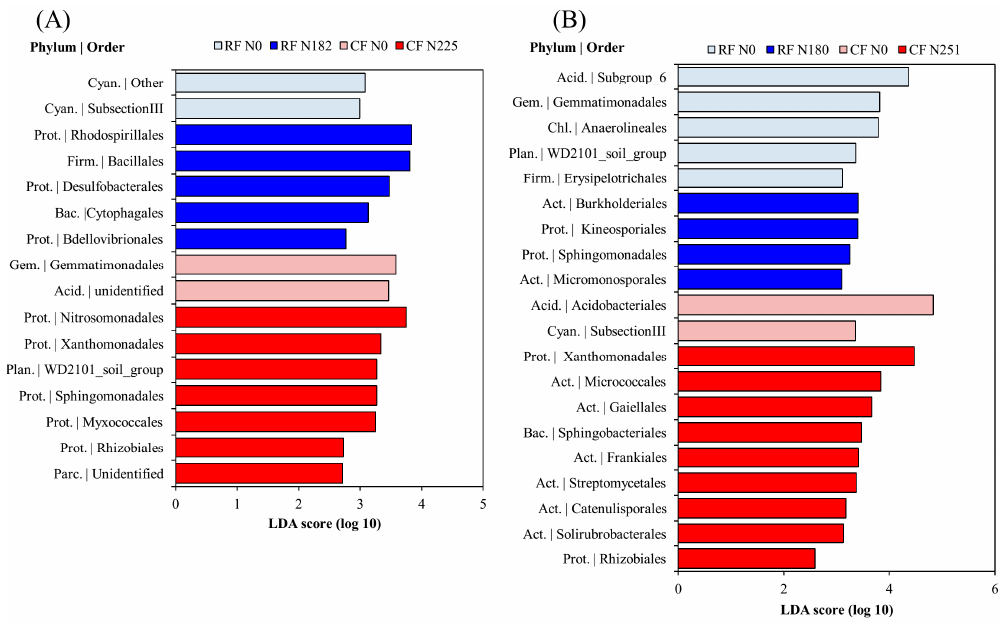
Figure 5. Bacterial key phylotypes (at the order level) significantly altered under RF and CF fertilization identified using linear discriminant analysis (LDA) effect size (LEfSe) in fluvo-aquic soil ( A ), black soil ( B